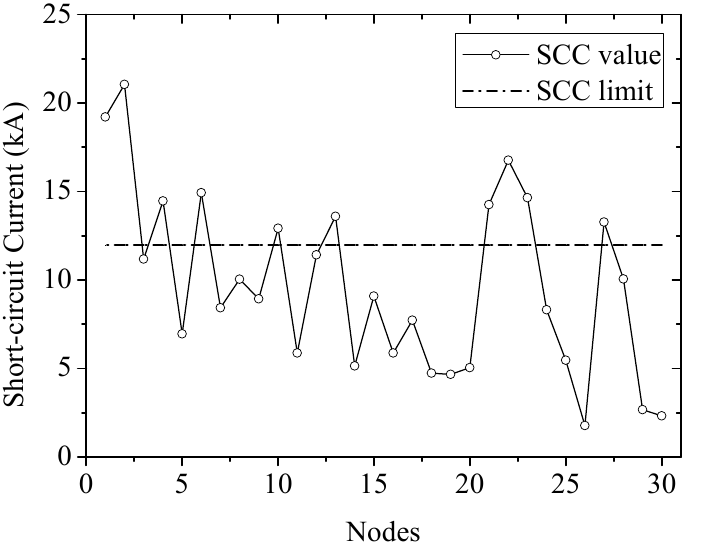
Figure 2. The short-circuit current magnitudes of all the buses in IEEE 30-bus system before transmission switching.